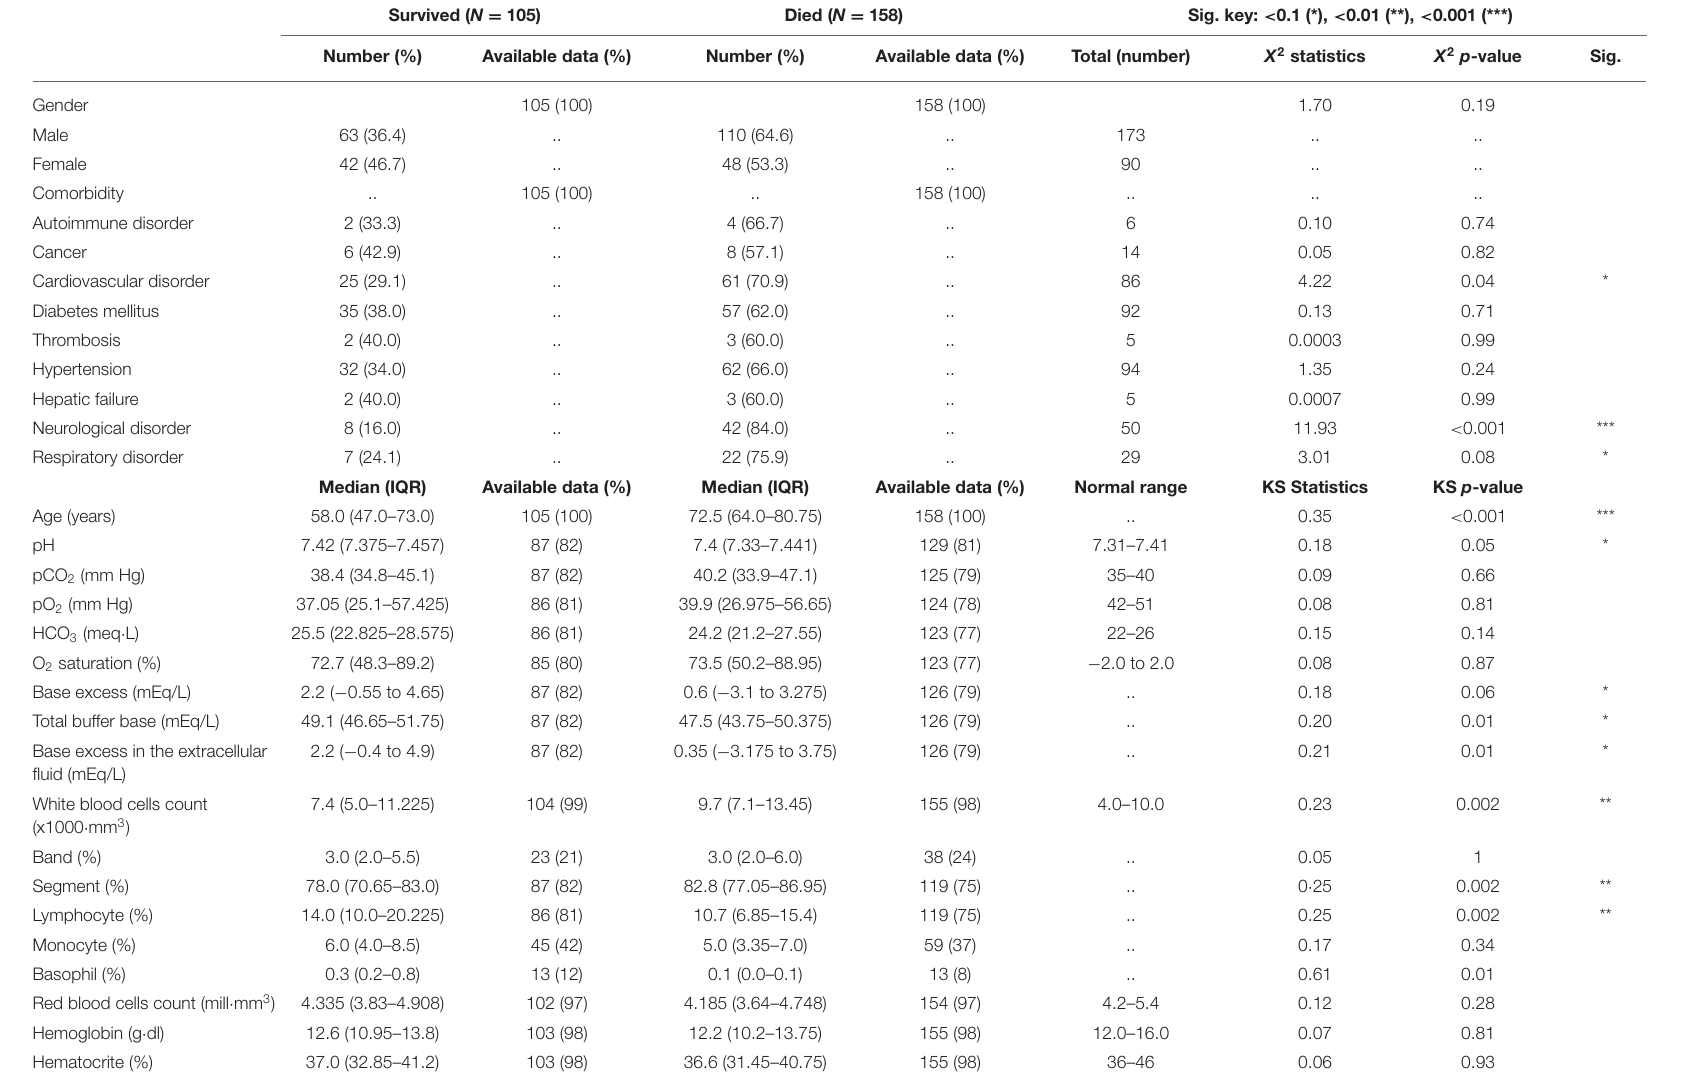
TABLE 2 | Characteristics of intensive care unit patients with COVID-19 in our